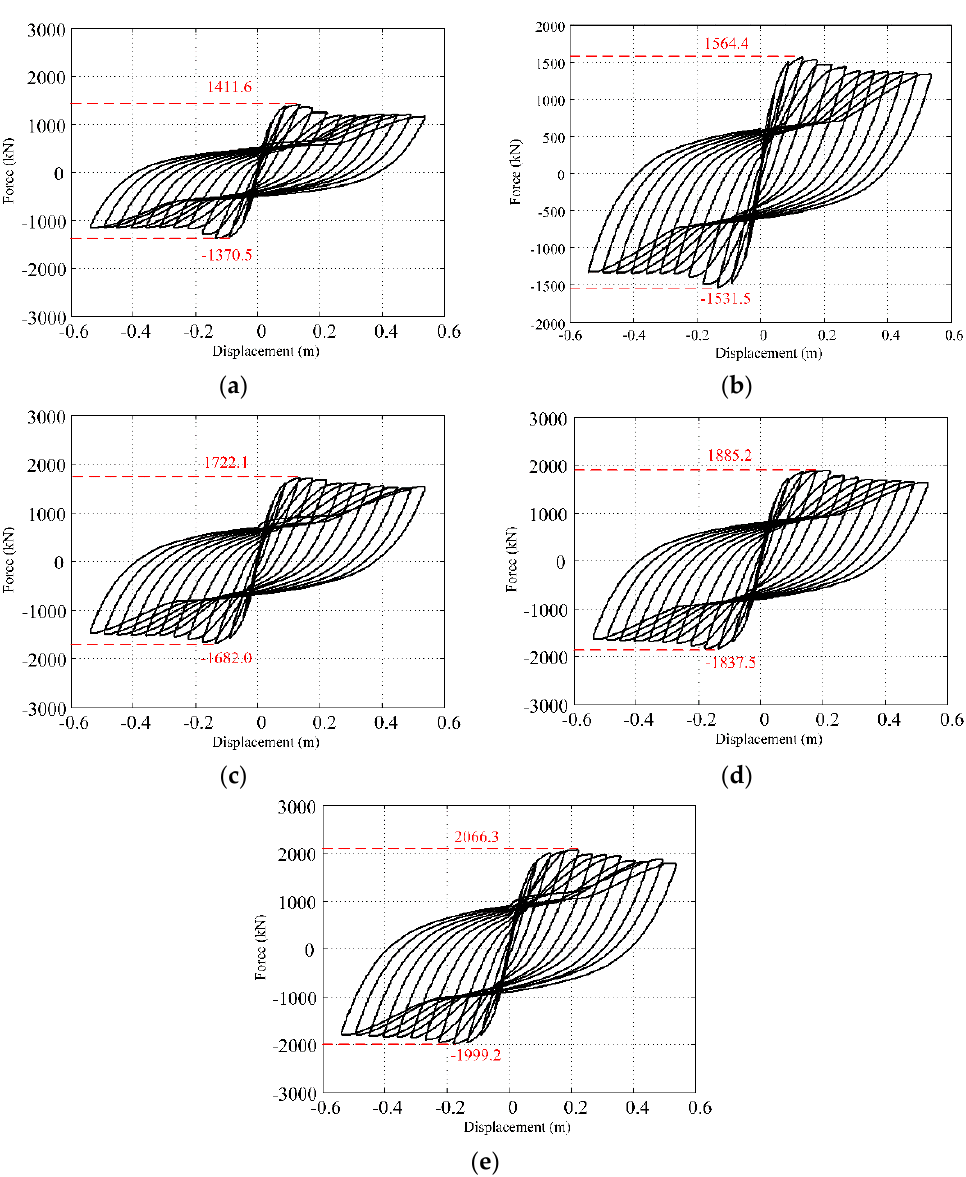
Figure 3. Hysteretic curves of a bridge pier with 5% corrosion strengthened by different thicknesses of steel plates. ( a ) 1 mm, ( b ) 2 mm, ( c ) 3 mm, ( d ) 4 mm, ( e ) 5 mm.